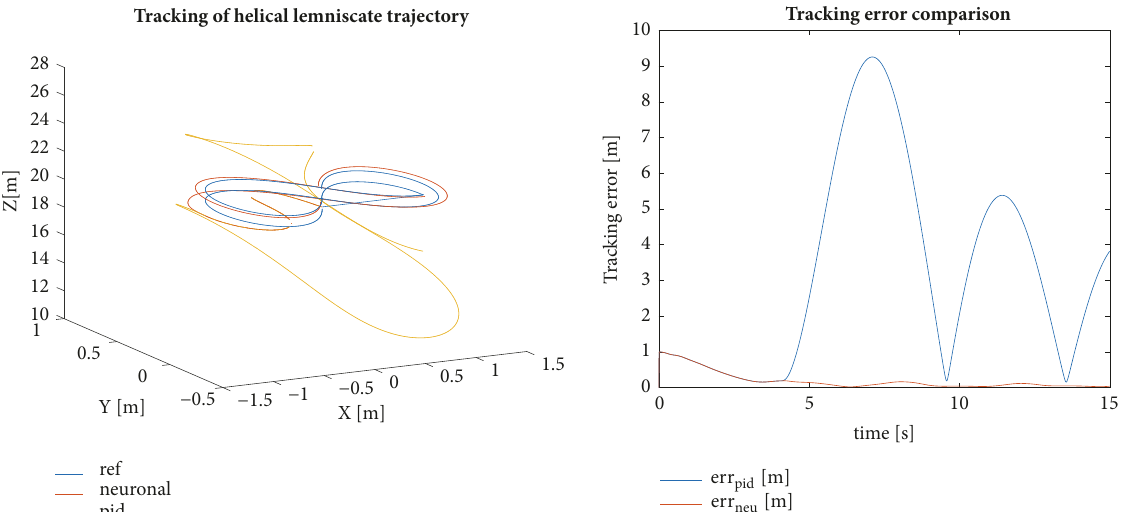
Figure 12: UAV tracking of a helical lemniscate trajectory with mass variation (left) and its tracking error (right).